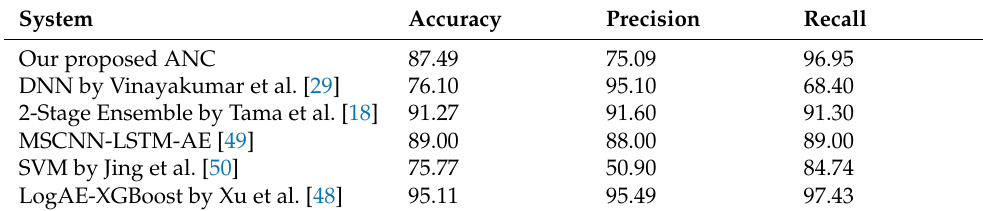
Table 14. Compare ANC with other research in UNSW-NB15 dataset.